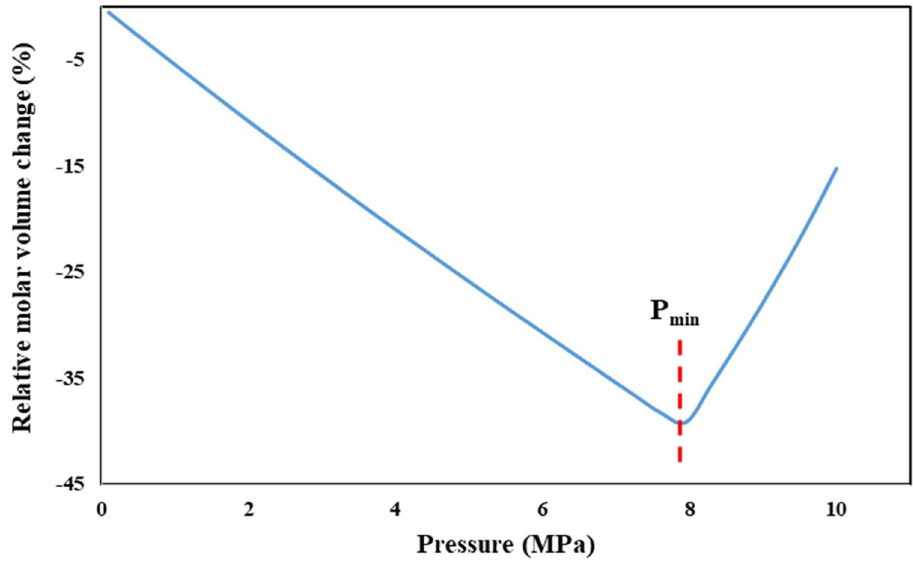
Figure 2. Relative molar volume change of the liquid phase vs. pressure, for the binary system (CO 2 –DMSO) at 328 K.